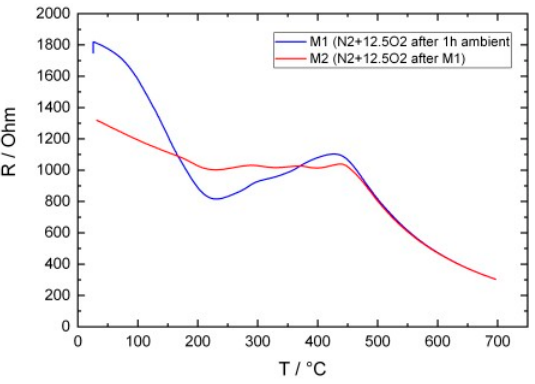
Figure 4. R(T) in N 2 + 12.5 vol% O 2 after exposure to ambient air and subsequent